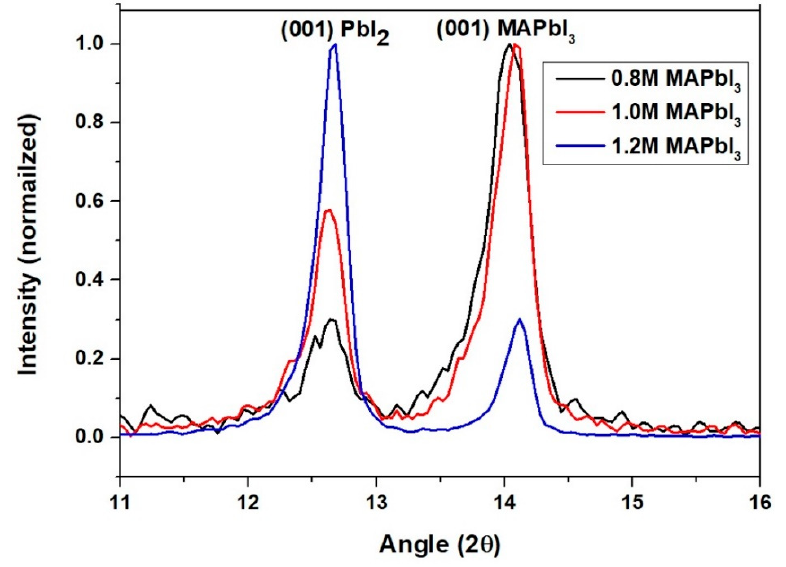
Figure 2. Normalized GI-XRD diffractograms of the perovskite films prepared using PbI 2 solutions of three different concentrations.